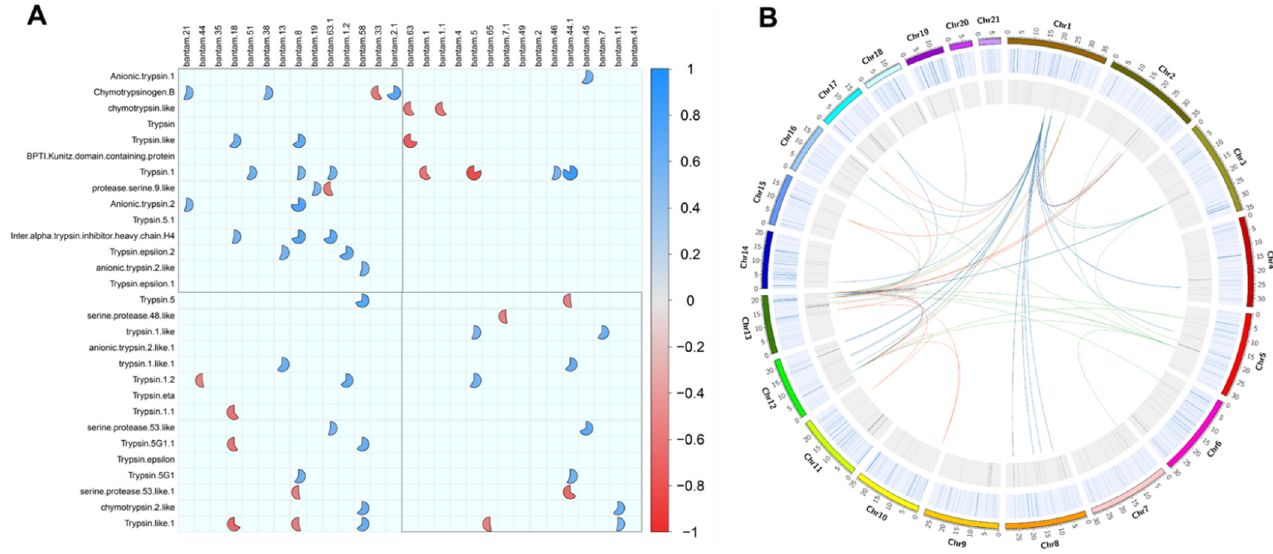
Figure 3. Correlation analysis of expression pairs between trypsin and bantam TPM values. ( A ) Corrplot analyses were conducted on differentially expressed trypsins and bantams (fold change > |4| and p -value > 0.01) among all of the data, including the exposure to the three delousing drugs. Only Pearson’s correlation values that were significant ( p -value > 0.01) are shown in the plot. Red pies correspond to significant negative correlations and blue pies to significant positive correlations. The completeness of the pies corresponds to the correlation level, where pies closer to a circular shape correspond to values more proximal to |1| in Pearson’s calculation. ( B ) Correlations linked to chromosome positions in the salmon louse genome. The two tracks correspond to heatmaps of reads mapped in genes annotated as trypsin, trypsin-like, and chymotrypsins (light blue track) and to heatmaps of annotated bantam miRNAs (gray track) in the sea louse genome. Colored links in the center of the plot correspond to significant negative correlations (r < − 0.95; p < 0.01) for the expression pairs between trypsin genes and bantam miRNAs for a specific delousing drug exposure, including resistant and susceptible populations. Blue links correspond to exposure to azamethiphos, green to deltamethrin, and red to cypermethrin.